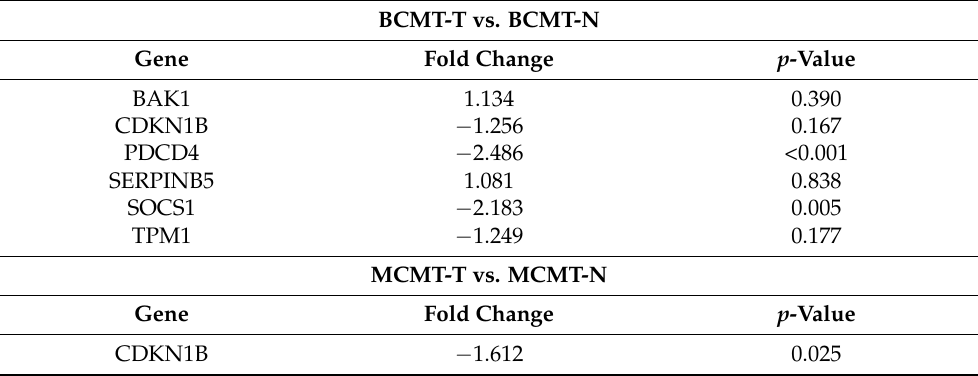
Figure 1. Volcano plot in canine mammary gland tumor for array-based miRNA. Red dots indicate upregulated miRNAs and grey dots indicate unsignificant miRNAs. Red and blue dotted line are threshold of fold change and black dotted line is threshold of p -value. ( A ) BCMT-T vs. BCMT-N; ( B ) MCMT-T vs. MCMT-N; ( C ) MCMT-T vs. BCMT-T (Figure 2). Table 1. The mRNA expression profile of miRNA-target